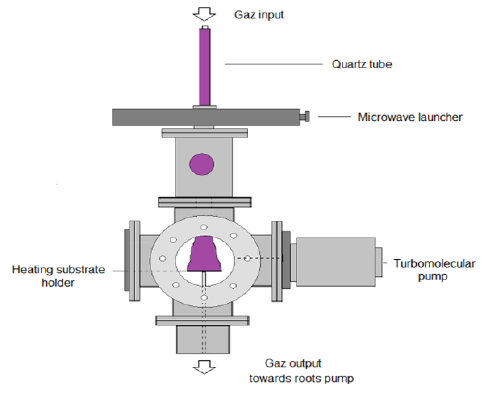
Figure 1. Experimental set-up [15].